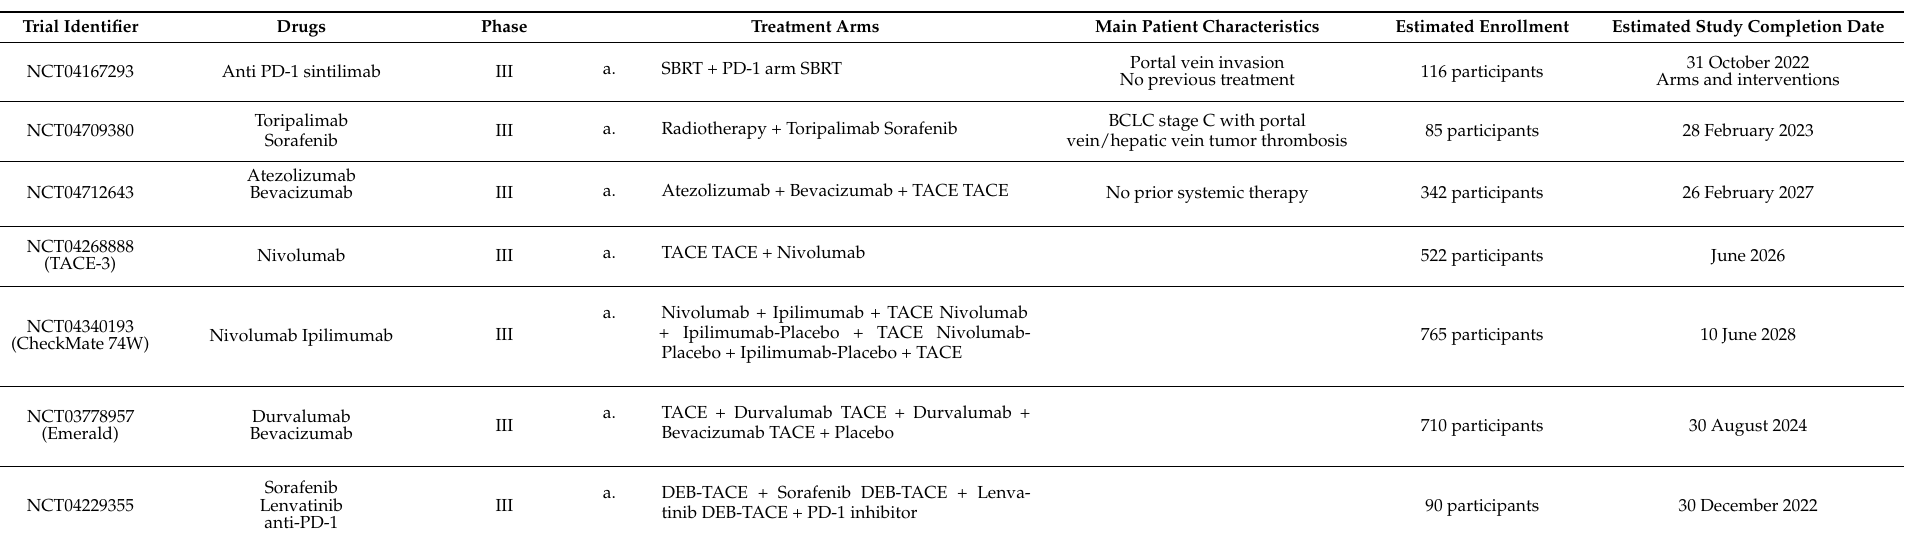
Table 2. Active phase III studies for immunotherapy plus locoregional therapies in HCC